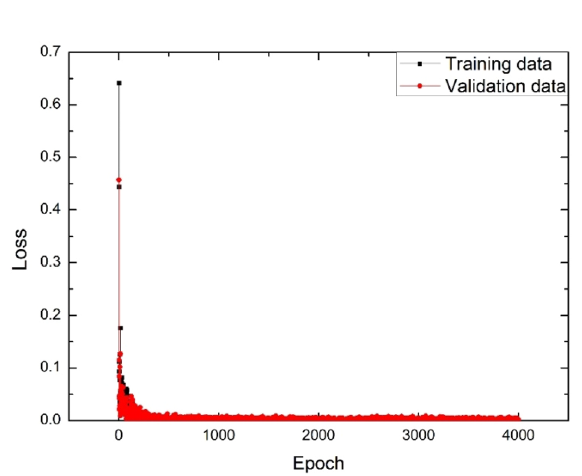
Figure 6. The loss for validation and training data for the 300 data of K value in 4000